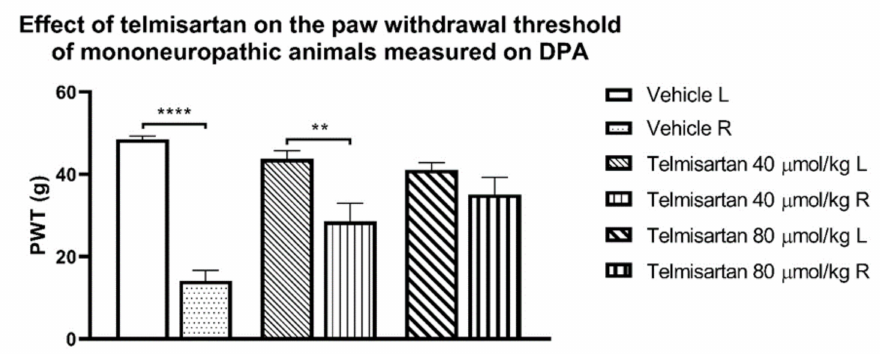
Figure 2. The analgesic effect of telmisartan measured on a dynamic plantar aesthesiometer (DPA) test at 120 min, after p.o. administration to mononeuropathic animals induced by partial sciatic nerve ligation rat model described by Seltzer et al. [98]. Columns represent the paw withdrawal thresh- old (PWT) of the animals in grams ± S.E.M. Asterisk indicates the significant differences between treatment groups or operated (R) and non-operated (L) hind paws (** p < 0.01 and **** p < 0.0001). Sta- tistical differences were determined with one-way ANOVA and Tukey post-hoc test. Data represent means ± S.E.M (n = 5 per group). (Kar á di, D. Á .; Al-Khrasani, M.; unpublished